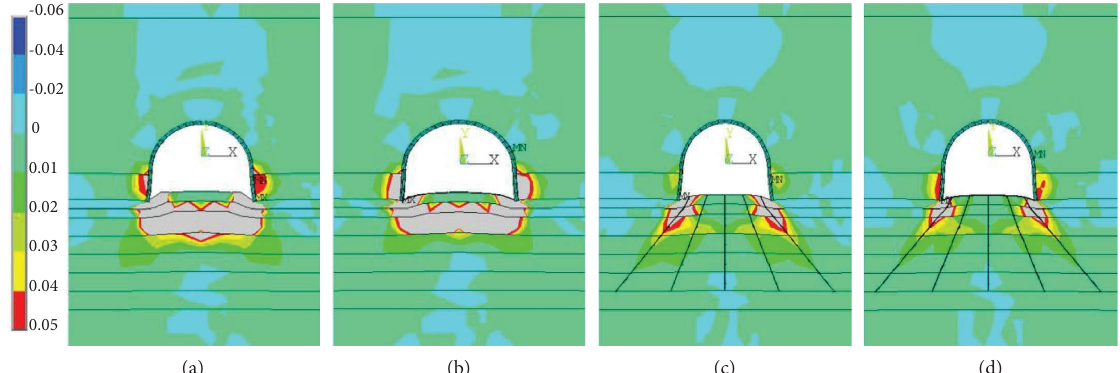
Figure 17: Total maximum principle strain distribution around the roadway: (a) without foor support; (b) with steel belt; (c) with rock bolts; (d) with rock bolts and steel belt.